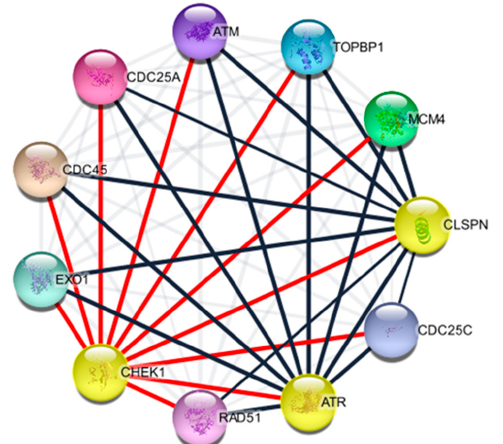
Figure 6. Identification of known and predicted structural proteins essential for CHEK1. The figure